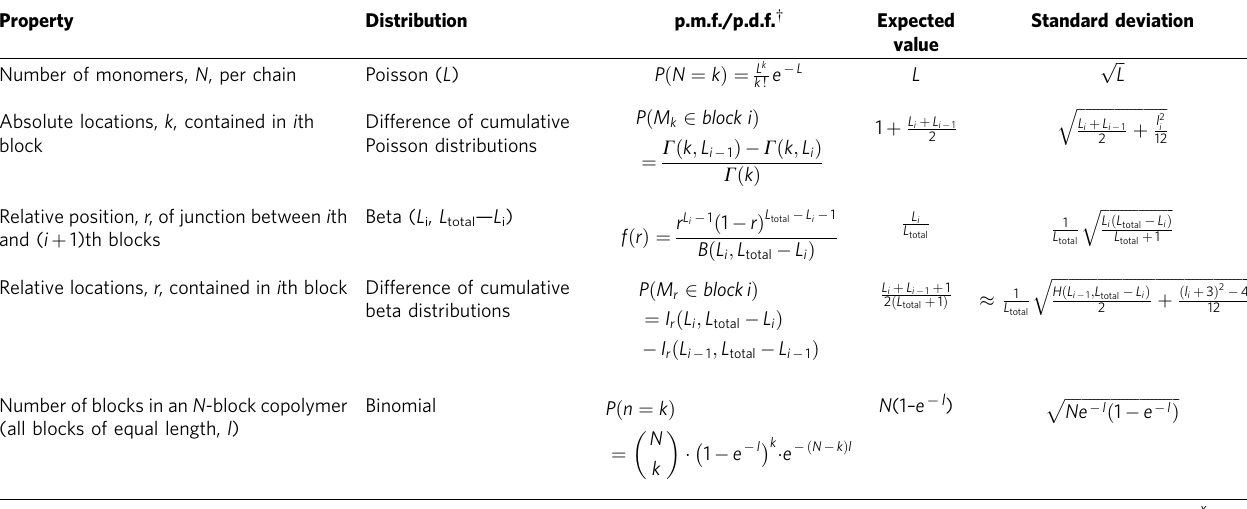
Table 1 | Probability distributions of various properties of Poisson-distributed block copolymers*. Property Distribution